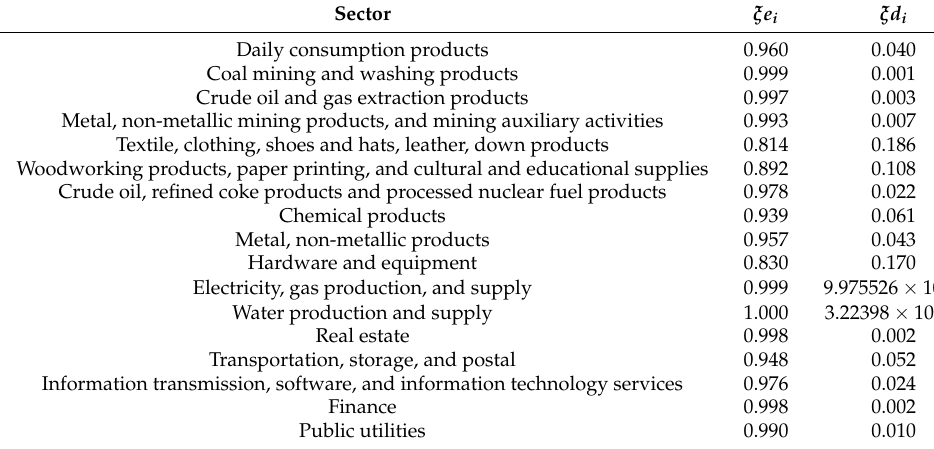
Table A7. The results of calibration of ξ e i and ξ d i .